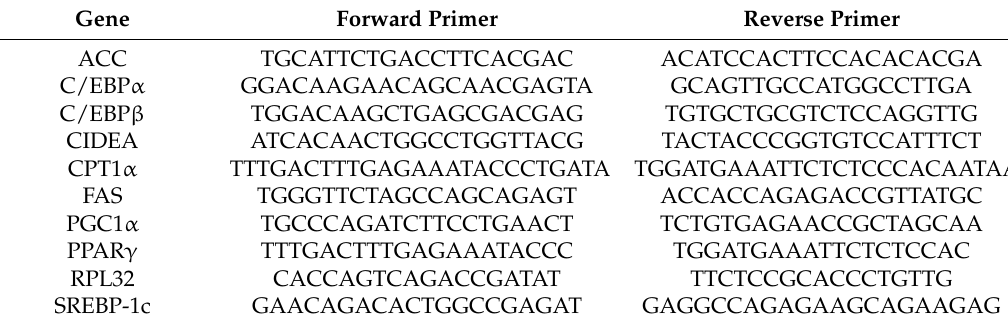
Table 1. Primers designed for quantitative real-time